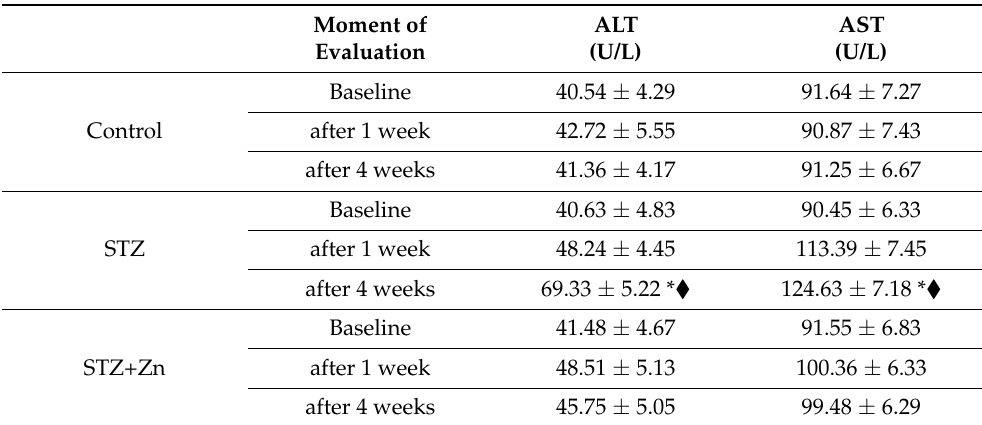
Table 4. The influence of Zn on blood levels of bilirubin and alkaline phosphatase in rats with experimentally induced diabetes. The numbers are presented as average ± S.D. for five animals in a group. * p < 0.05 versus control; (cid:7) p < 0.05 versus baseline. Moment of Total Evaluation